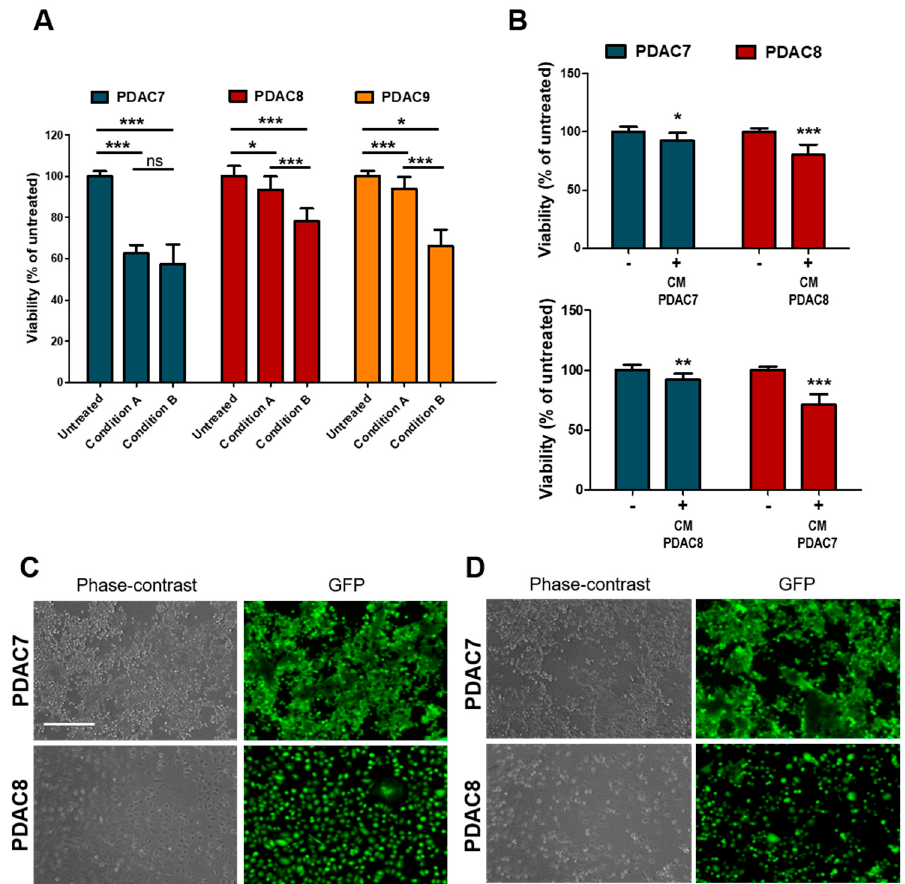
Figure 4. Response of 2D primary PDAC cultures to Irradiation. ( A ) Bar plots showing changes in cell viability after 6 Gy X-Rays in three primary 2D PDAC cultures under different conditions. Cell culture viability displayed as mean from three independent experiments. Condition A, cell culture medium was aspirated after treatment and medium replaced, no replaced of the treated culture medium in condition B. ( B ) Changes in cell viability of two primary PDAC cultures exposed to media from irradiated and non-irradiated cell lines. Cell culture viability are means from three independent experiments. ( C , D ) Representative Phase Contrast and Fluorescence microscopy images of PDAC cell lines exposed to conditioned media from untreated C and treated D cell lines as in B. Fluorescent signal for calcein was acquired after 30 min of incubation with CellTrace Calcein Green AM, using EVOS Cell Imaging System. Scale bar, 400 µm. *, p > 0.05; **, p < 0.01; ***, p < 0.001 by student t test.